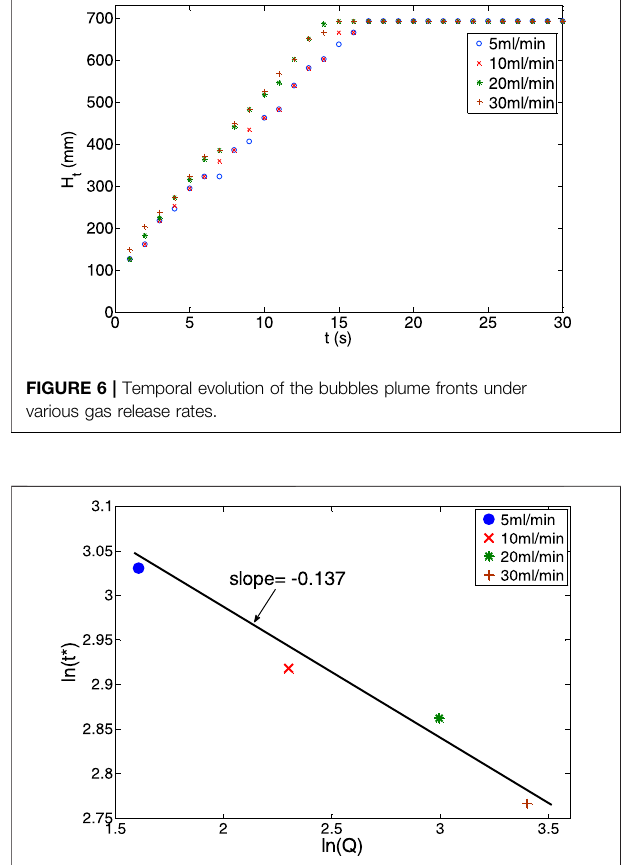
FIGURE 7 | Characteristic time ( ln ( t p )) versus gas release rate ( ln ( Q )) .